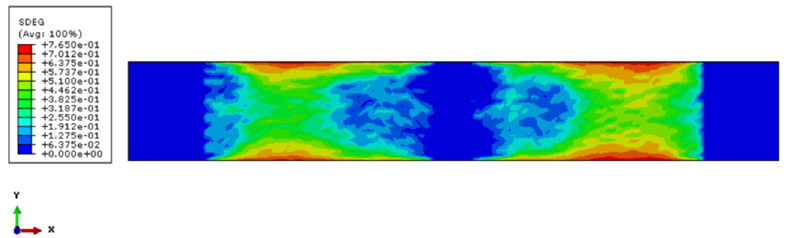
Figure 15. Damage parameter field distribution on the PyC interface.